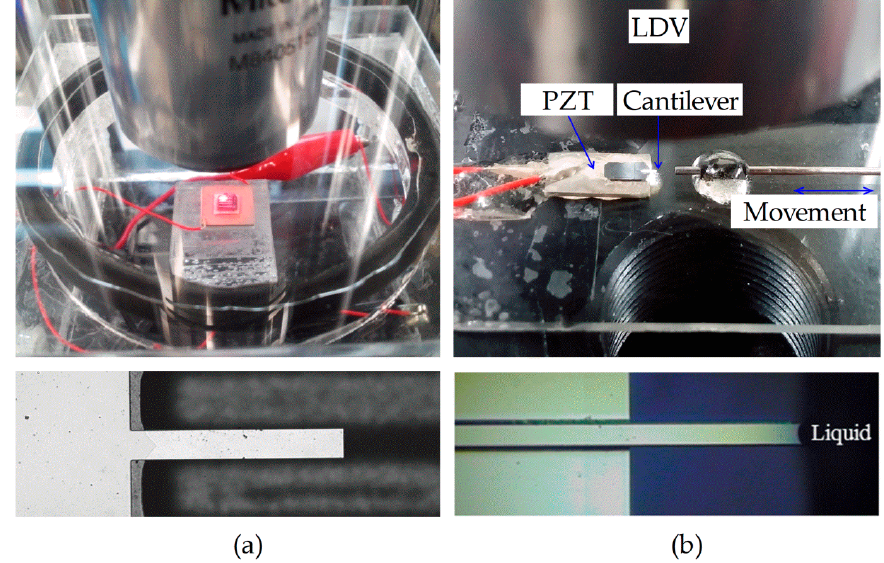
Figure 2. ( a ) Experimental setup for the measurement of the gas properties using a microfabricated nanoscale-thickness cantilever in a gas chamber and ( b ) the liquid properties using a microscale-thickness cantilever partially immersed in liquid.